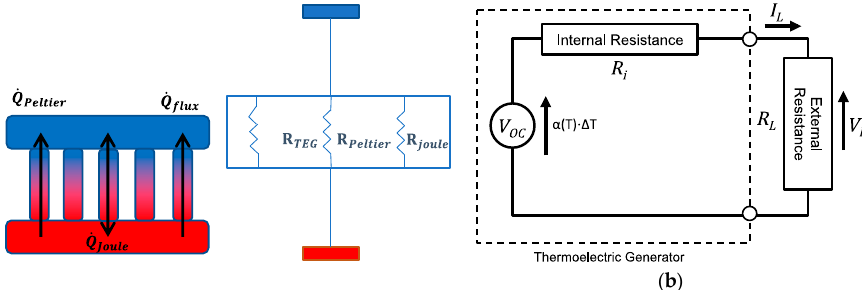
Figure 21. Model of TEG heat fluxes with equivalent thermal ( a ) and electrical circuits ( b ) [149].